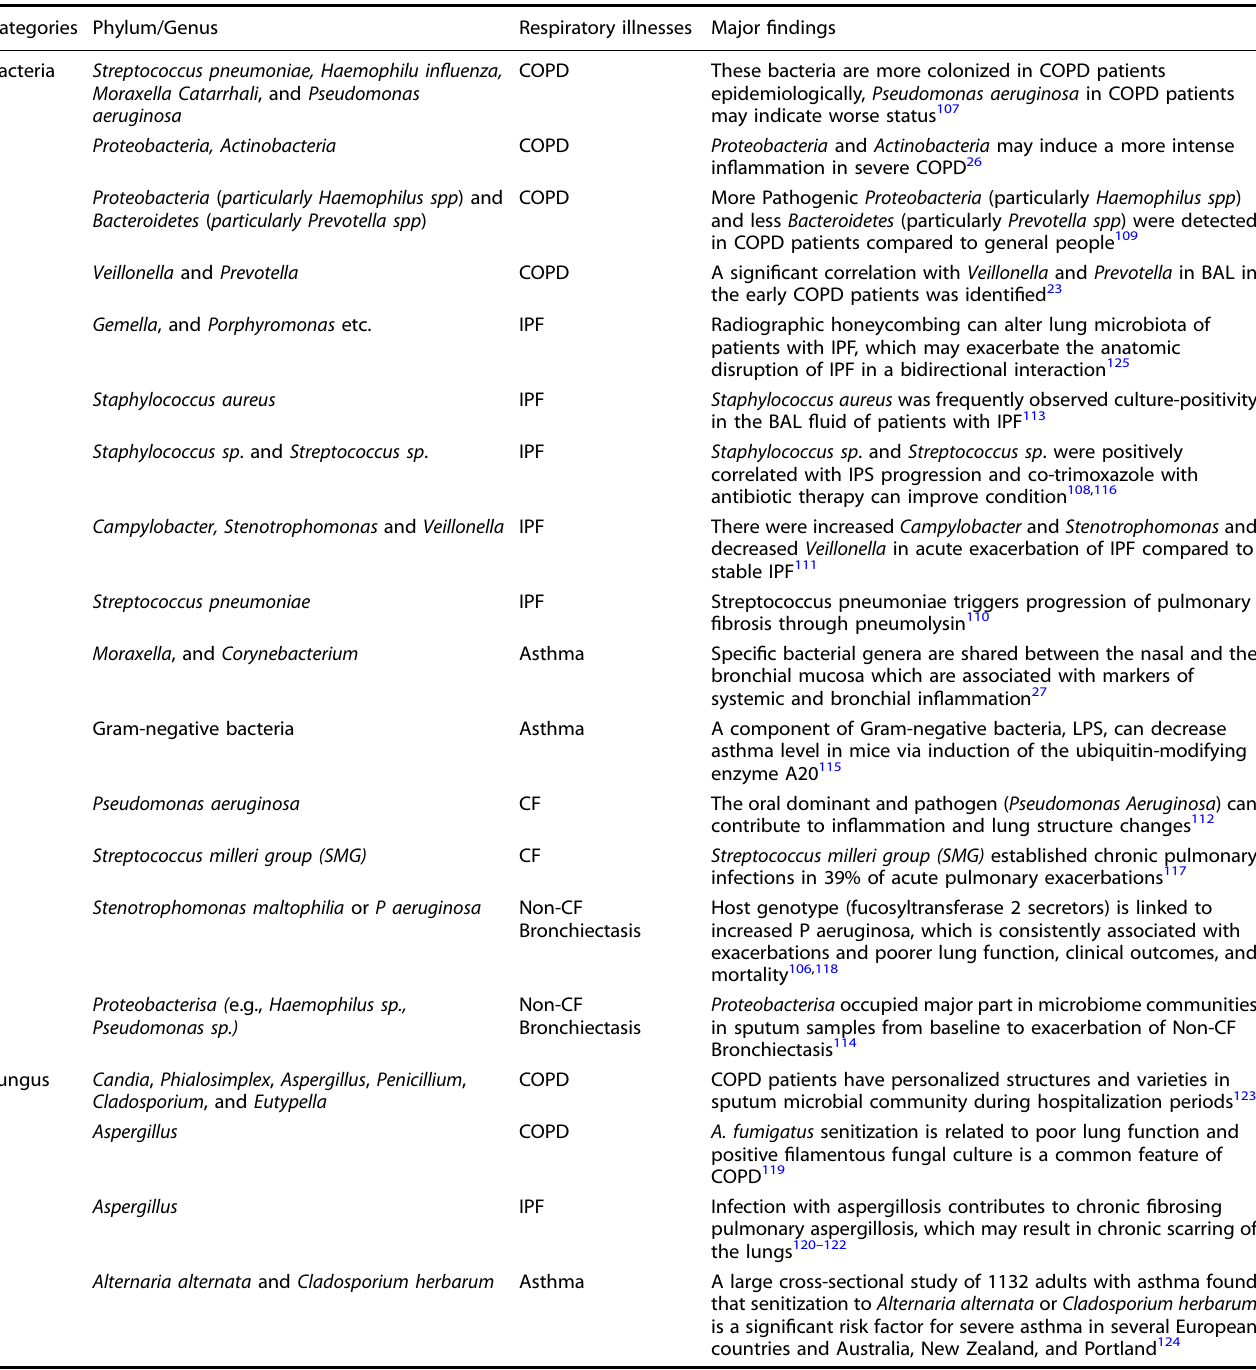
Table 2. Possible correlations of lung cancer microbiome with other respiratory